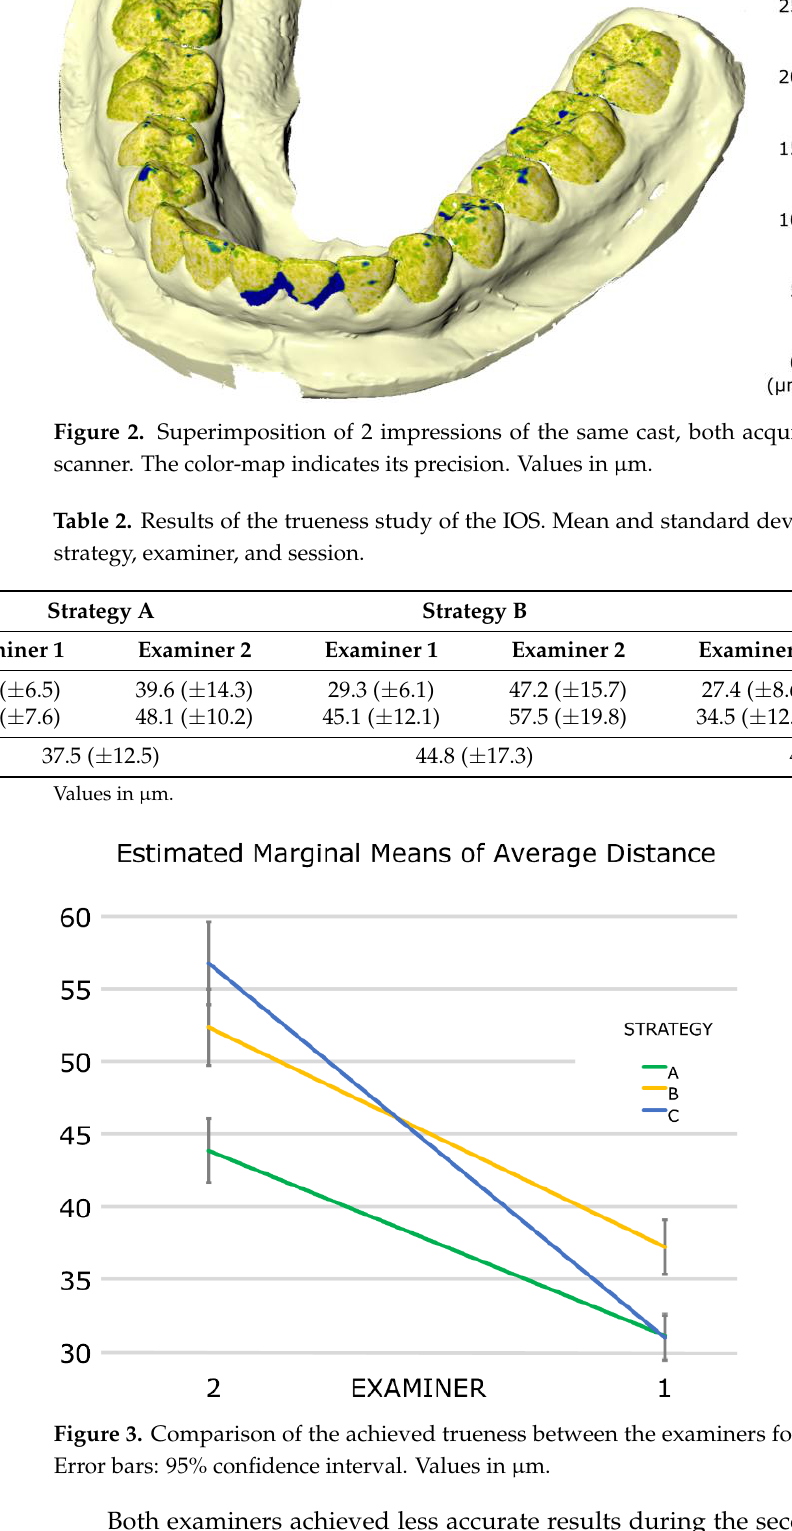
Table 3. Results parameter estimates of the General Linear Model. Parameter